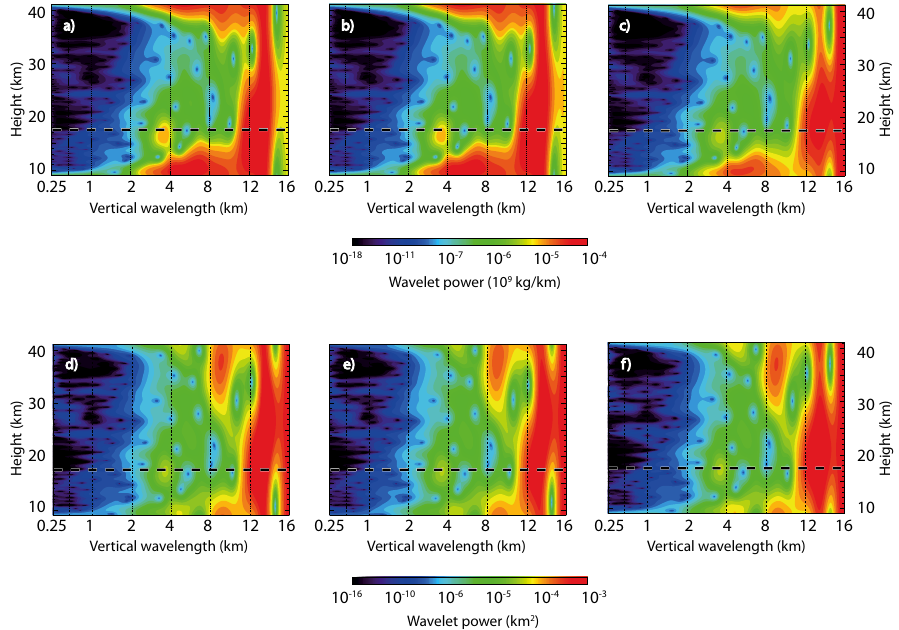
Figure 5. Wavelet power spectra of various perturbations resulting from different background states: scaled normalized density perturbations resulting from the (a) sixth-, (b) fifth- and (c) fourth-order polynomial fits; normalized density perturbations resulting from the (d) sixth- and (e) fifth-order polynomial fits; normalized dry temperature perturbations resulting from the (f) sixth-order polynomial fit.